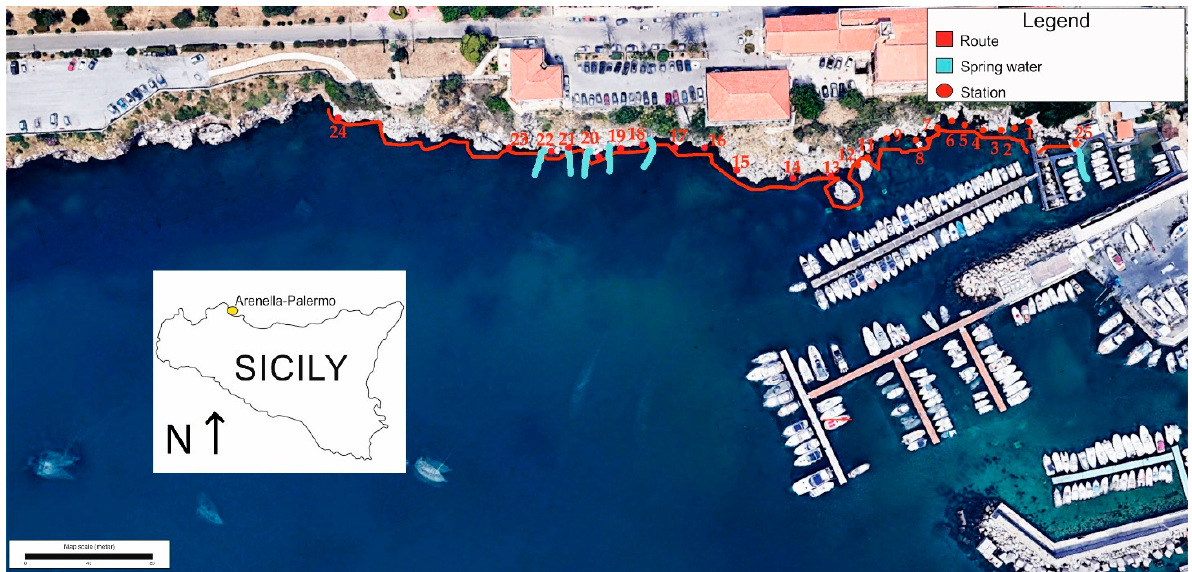
Figure 10. Location of 25 FTN sites along a 311-m stretch of coast in Palermo.